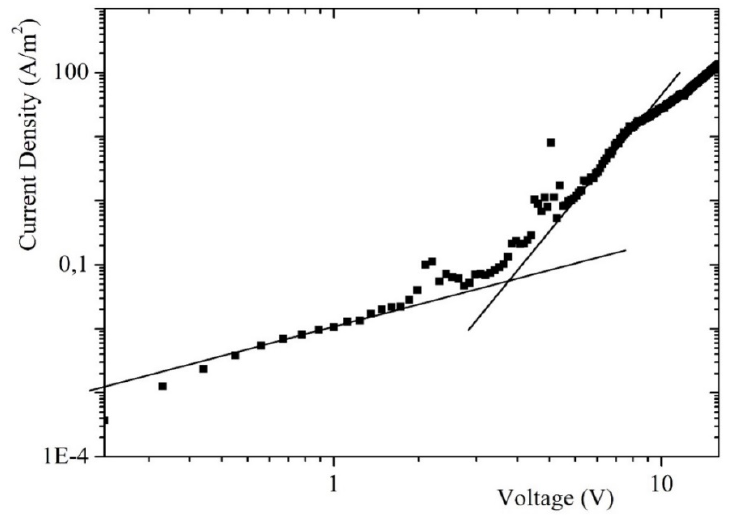
Figure 4. Current density versus voltage characteristic of the device realized with the 10 wt.% C1-PVK blend.